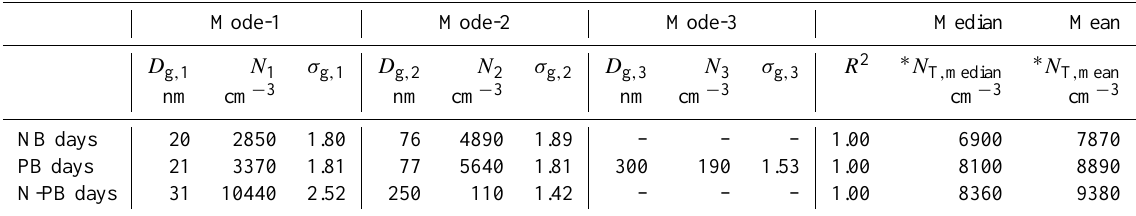
Table 5. Median number size distribution log-normal parameters of NB, PB and N-PB days. The D g ,i , N i and σ I represent the geometric diameter, median number concentration and the geometric standard deviation, respectively. The correlation coefficient ( R ) between observed and fitted size distribution is also shown. ∗ The median and mean total number concentrations ( N T , median and N T , mean ) are calculated from the measured values instead of the fitted ones.